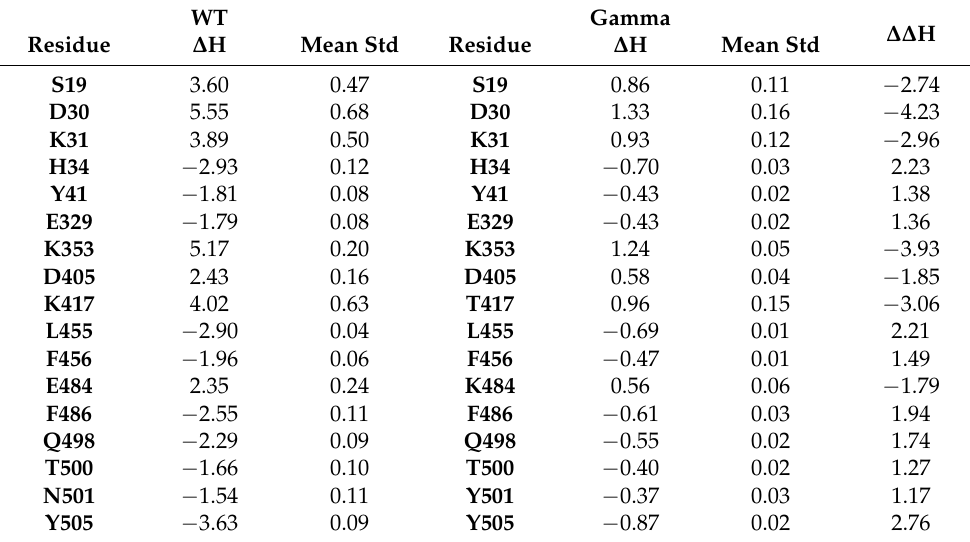
Table 2. Major residue contributions to the binding affinity ( ∆ H). Main residues contributing to binding affinity changes. The binding energy compensation is highlighted in red for the K417T, E484K and N501Y mutations. All values are in kcal/mol. Shaded cells correspond to hACE-2 residues. WT